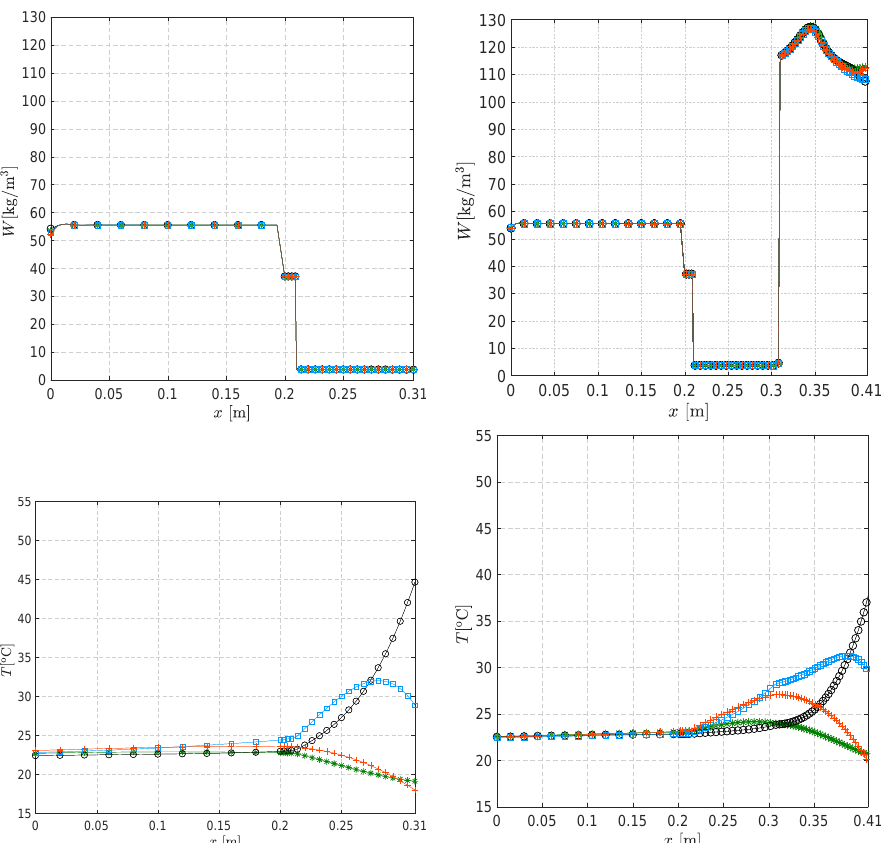
Figure 20. Evolution of the relative humidity, water content and temperature throughout the cross section of the constructive solution containing ICB 0.10 m thick, without and with substrate on the wall facade: ( ∗ ) t = 216 h; ( ◦ ) t = 222 h; ( (cid:3) ) t = 228 h; (+) t = 234